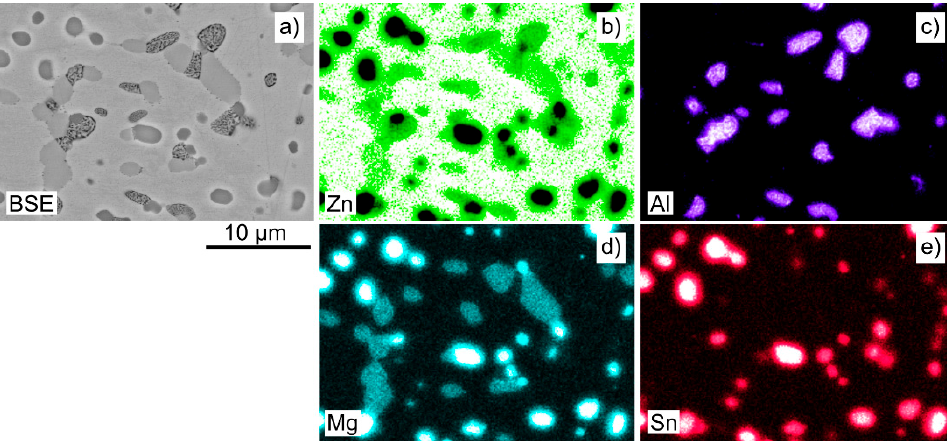
Figure 2. Example of an element distribution in the microstructure as identified by EDX.